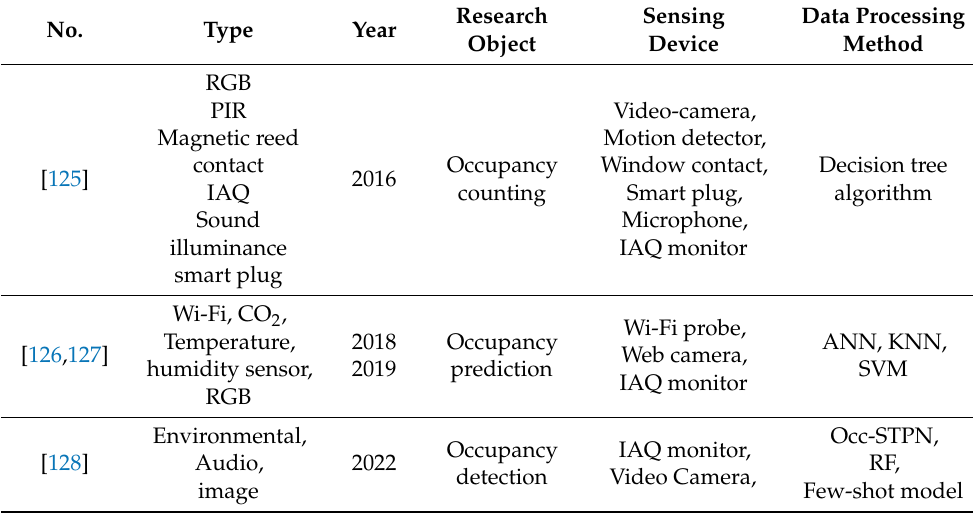
Table 9. The list of references for the fusion of multi-sensing system.